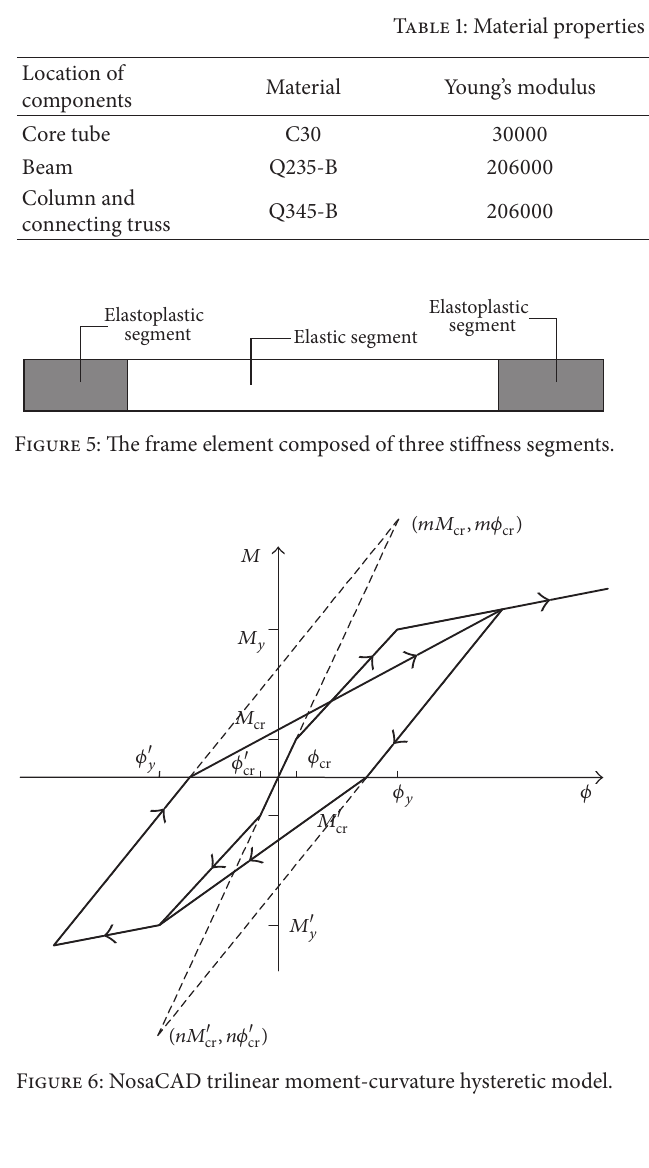
five. Lateral stiffness of some floors is not more than 70% of that of adjacent upper floor or 80% of average lateral stiffness of 3 adjacent upper floors. Setback horizontal area of 14th floor is bigger than 25% of 13th floor’s horizontal